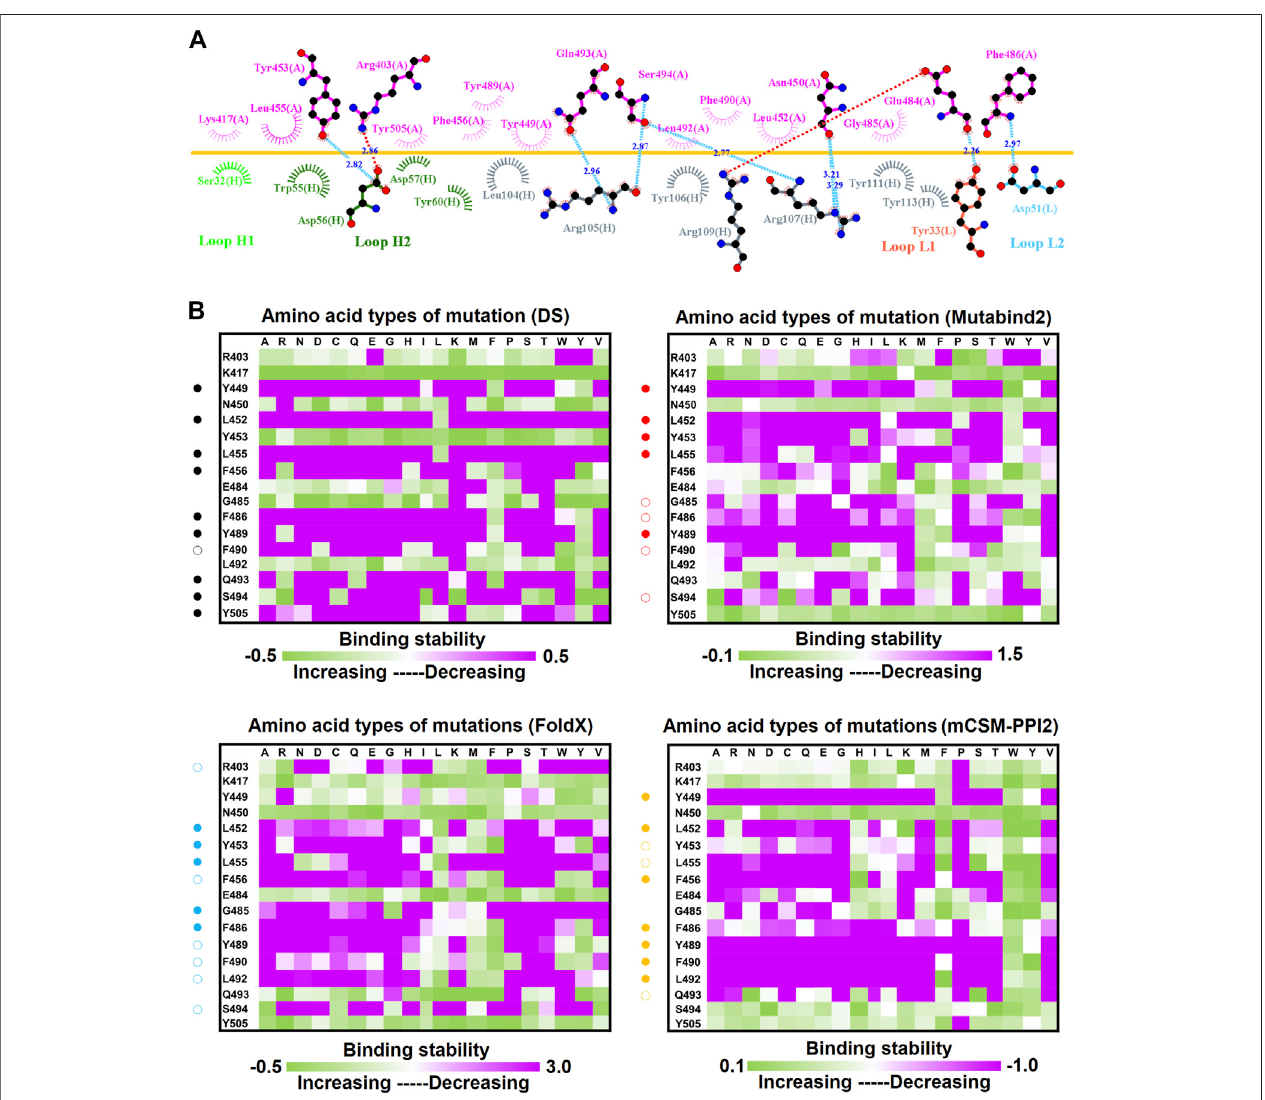
FIGURE 5 | Mutational heatmaps of the RBD targeting antibody CT-P59. (A) LIGPLOT was employed to examine the interaction network of CT-P59 and SARS- CoV-2 RBD. The RBD and light and heavy chains of CT-P59 were labeled A, H, and L, respectively. The golden yellow line denotes the interface of the RBD – CT-P59 complex.TheinteractiveresiduesoftheRBDarelabeledandcoloredmagenta.Thesalt-bridges,hydrogen bondsandhydrophobicinteractionsarerepresentedbyred, cyandashesandarcswithspokesradiatingtowardtheligandatomswithwhichtheycontact. (B) ThemutationalbindingstabilitiesofRBDvariantstoCT-P59were estimated using FoldX, MutaBind2, DS 3.5, and mCSM-PPI2. The unit of binding stability was kcal/mole, and the obtained values were employed to create the heatmaps. Green (increased stability) and purple (reduced stability) were used to generate a color gradient and were applied in each box. In each heatmap, the moderately and signi fi cantly reduced stabilities were labeled with hollow and solid circles,